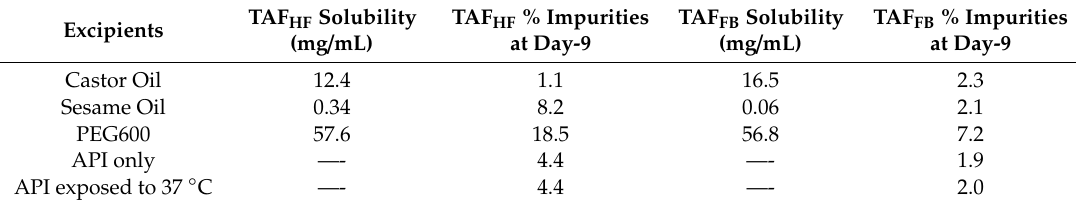
Figure 1. ( Left ) A digital camera image of the biodegradable implant. ( Right ) A schematic of a poly( ε -caprolactone) (PCL) reservoir-style implant for sustained delivery of tenofovir alafenamide (TAF) formulations. Table 1. The solubility and chromatographic impurity of TAF FB and TAF HF within various pharmaceutical grade excipients identified in the FDA’s inactive ingredient list.